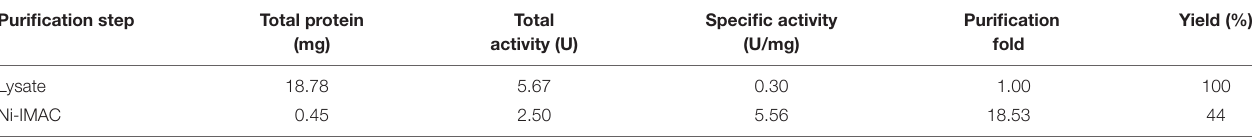
FIGURE 5 | (A) The 3D superposition between CelRH5 and some structural neighbors. (B) The catalytic Glu and His 3D superposition between CelRH5 and some structural neighbors. (C–F) Evidence for the distance between the two catalytic Glu and His involved in the active center in CelRH5 and some structural neighbors 3MMU (D) , 3RXY (E) and 4YHE (F) . TABLE 3 | Summary of purification of CelRH5 cellulase from 150 mL of E. coli TOP10/pBAD/ celRH5